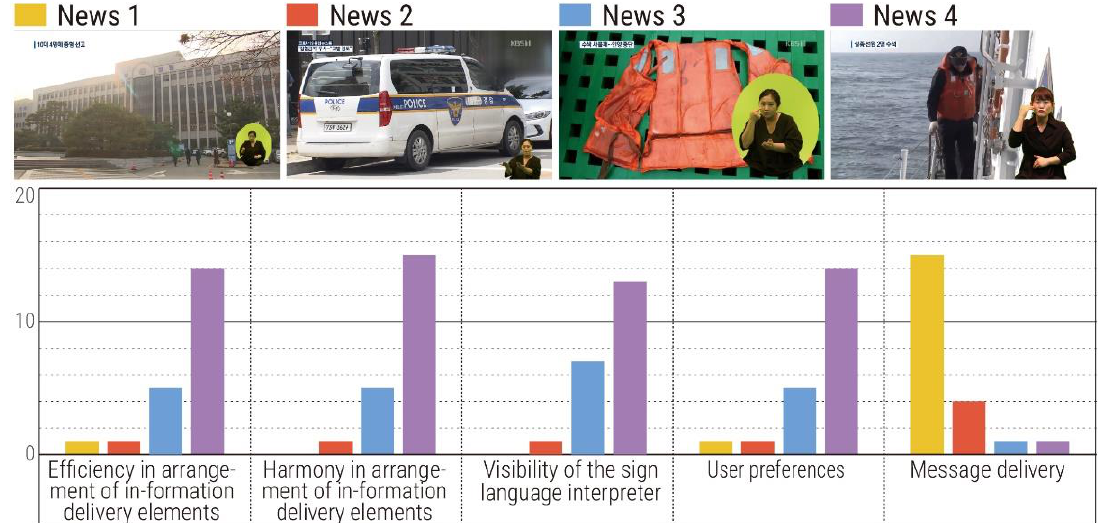
Figure 10. Results with news cases.